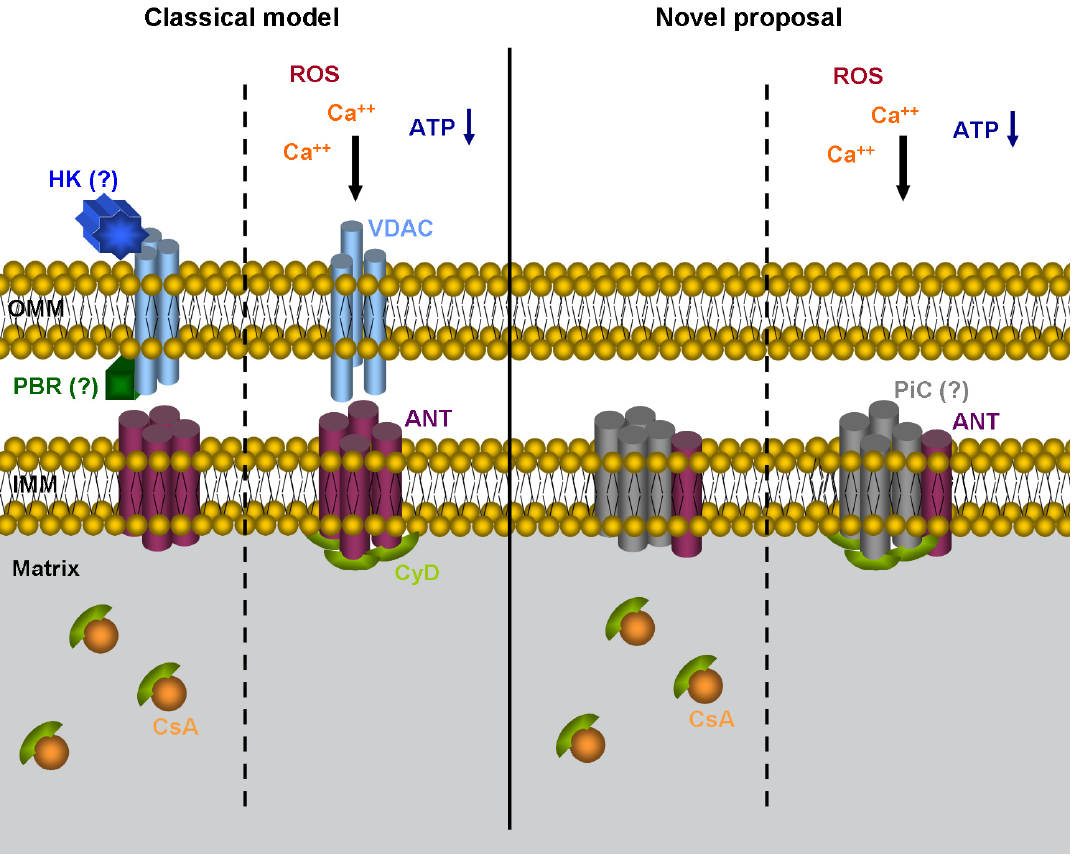
Figure 3. Comparison of the classical (left side) and novel models (right side) of the mitochondrial permeability transition pore (PTP). The role of hexokinase (HK),